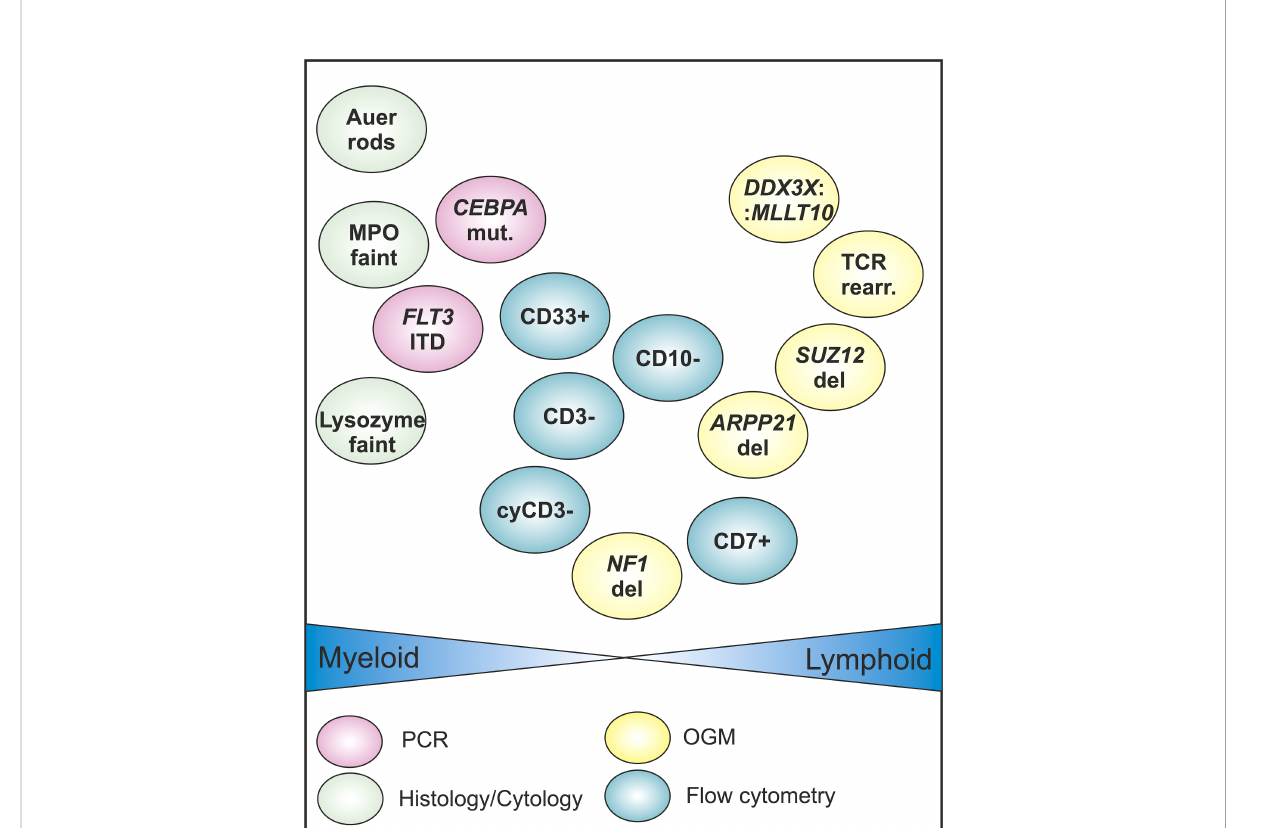
FIGURE 4 Graphical overview of selected diagnostic results obtained by different methodologies: results by optical genome mapping (OGM) are stained in yellow, PCR panel results in pink, histology results in green, and fl ow cytometry results in blue. The fi ndings are positioned depending on their probability of occurrence in myeloid and lymphoid cells. The positioning re fl ects a general orientation and is not scaled. OGM fi ndings are rather found on the lymphoid side. Cy, cytoplasmic; del, deletion; ITD, internal tandem duplication; MPO,